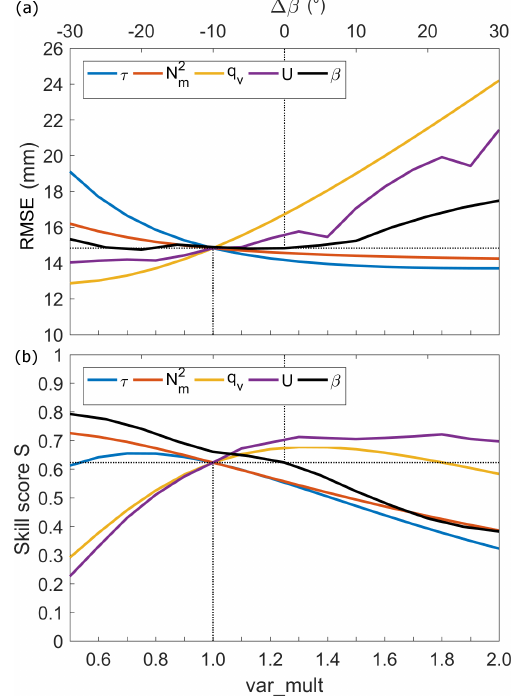
Figure 9. Changes in (a) RMSE, and (b) skill score S for per- turbed values of N 2 m , q v , U , β , and τ , with a multiplicative fac- tor (var_mult), and changed (cid:49)β , for 31 May 2013. The dotted lines indicate the values of the reference run.